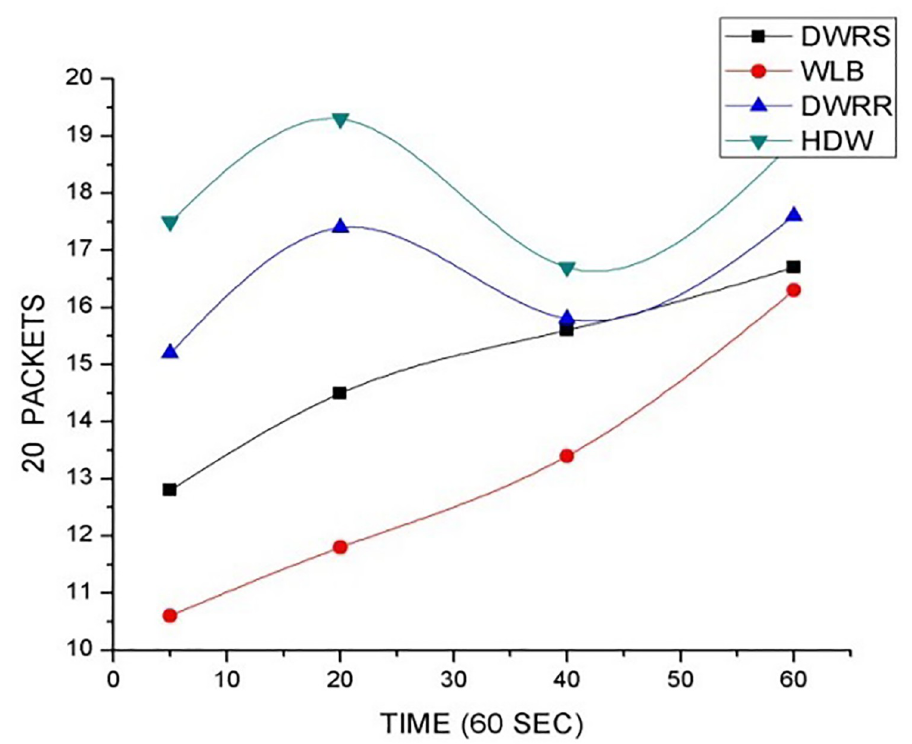
Fig 6. Comparative graph analysis of